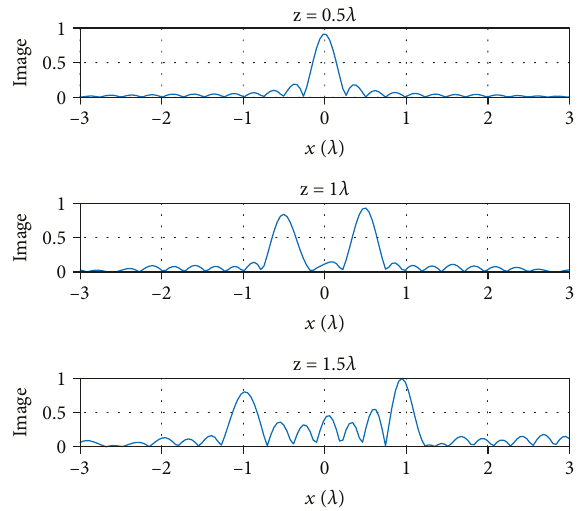
6: Reconstructed images when using 9 resonant dipole antennas. For this example, the parameters are z =1.5 λ , d = λ , d =2 λ , s = λ /8, and D =0.25 λ . The auxiliary z 3 2 3 equations for lossless media proposed in [32] have been employed to improve the quality of the images. These results are with SNR =20dB.